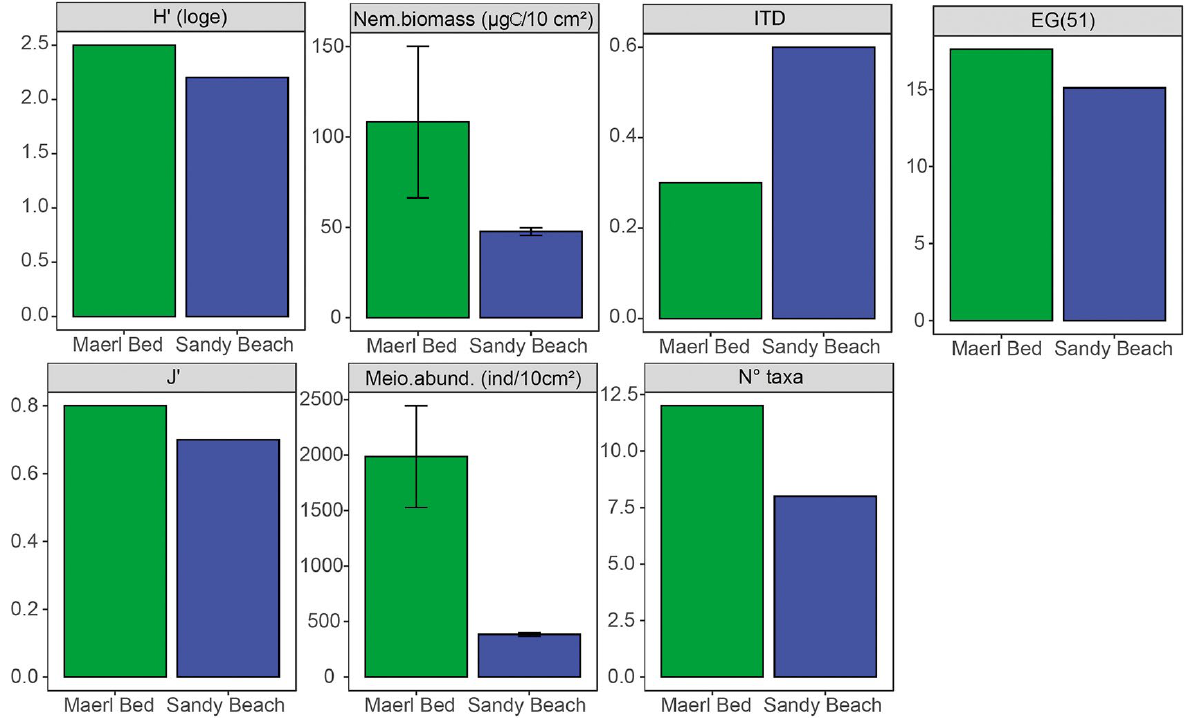
Fig. 4. – Shannon index (H’), nematode biomass (μg of C/10 cm 2 ), trophic diversity index (ITD) values, expected genus number (EG (51)), equitability evenness (J’), meiofaunal abundance and number of higher meiofauna (N° taxa). Vertical bars are standard deviations.